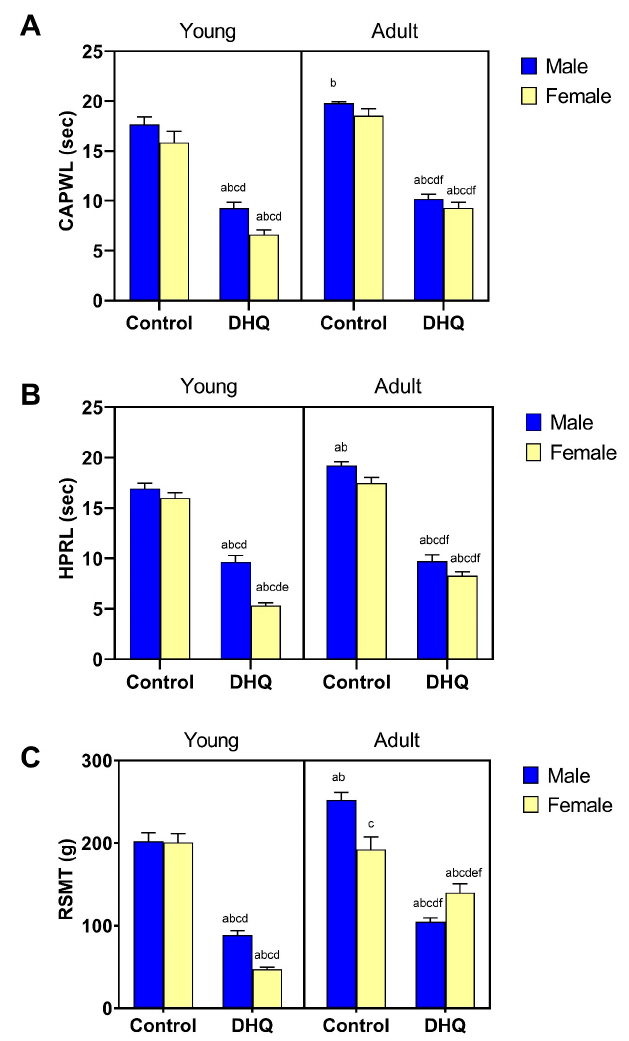
Figure 2. Sensory impairments instigated by diiodohydroxyquinoline administration in young/adult male/female rats. Panels represent: ( A ) paw withdrawal latency (CAPWL) in the cold allodynia test, ( B ) reaction latency (HPRL) in the hot plate test, and ( C ) mechanical threshold (RSMT) in Randall–Selitto test. Each bar with a vertical line represents the mean ± S.D. of 10 rats per group. a vs. control young male, b vs. control young female, c vs. control adult male, d vs. control adult female, e vs. DHQ young male, and f vs. DHQ young female using three-way ANOVA followed by Tukey’s post hoc test; p < 0.05. DHQ; diiodohydroxyquinoline.